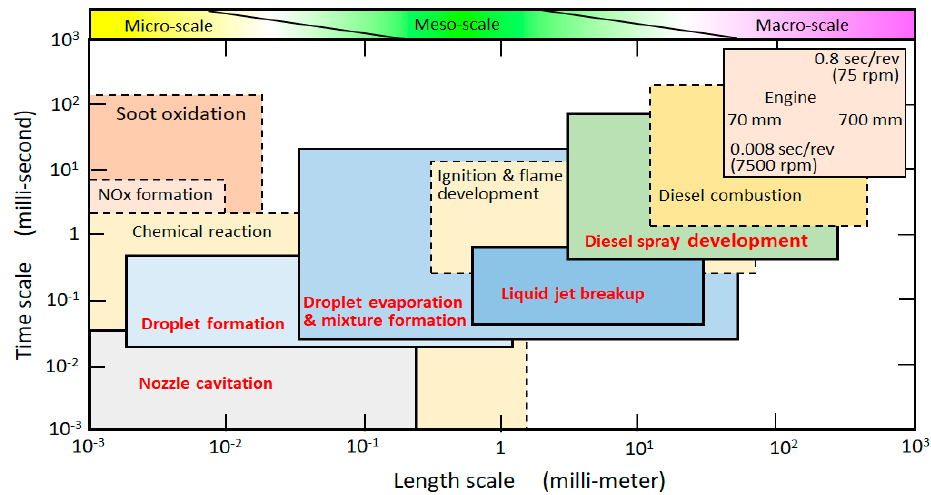
Figure 1. Time and length scales of diesel spray.